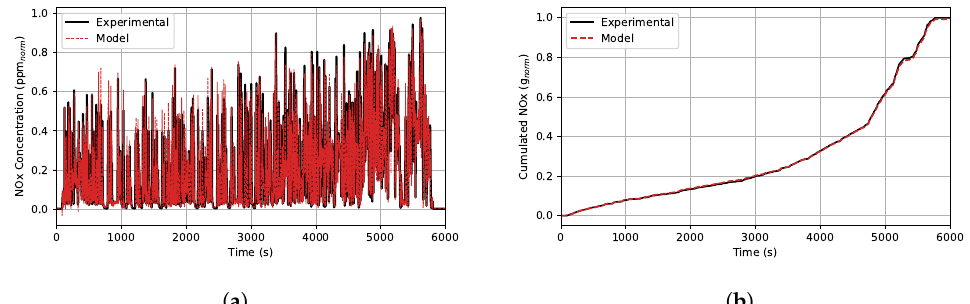
Figure 19. Comparison between experimental and modeled NOx emissions on the second test RDE cycle. ( a ) Instantaneous NOx concentration. ( b ) Cumulated NOx mass. Normalization makes the final experimental value equal to